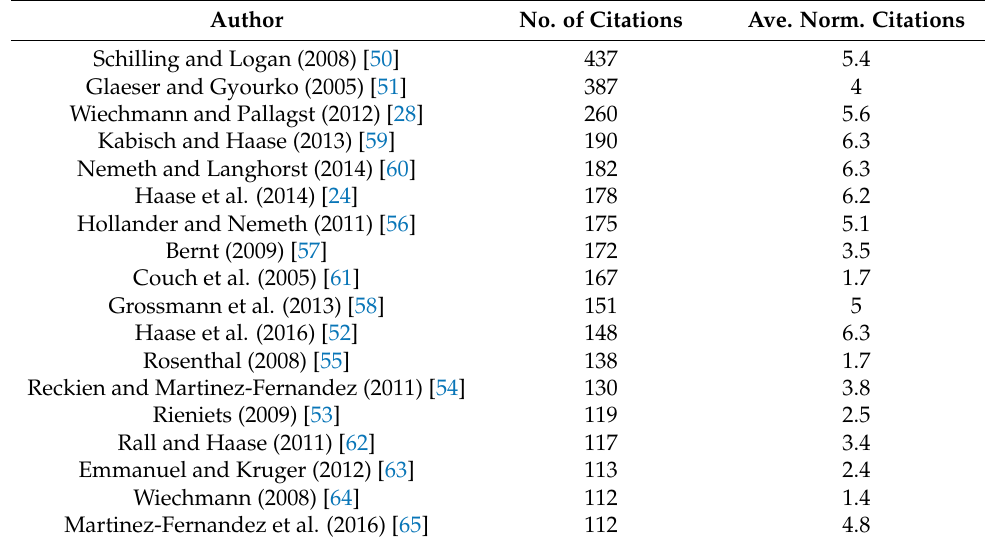
Table 4. Details of articles citations in SCT.